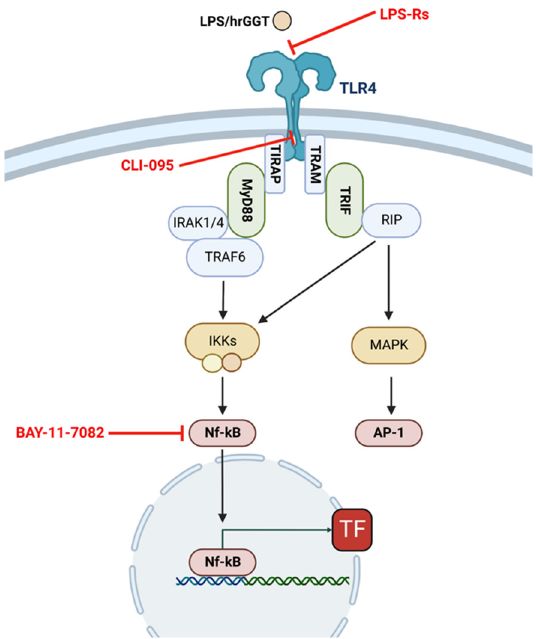
Figure 12. The NF- κ B activation pathway via TLR4 and the mode of action of pharmacological probes formulated to block TLR4 receptor in different signaling steps. TLR4 activation by ligands (LPS or hrGGT) triggers the TLR4 signaling cascade that activates NF- κ B, allowing it to translocate to the nucleus and activate TF gene transcription. Inhibitors are shown in red: LPS-Rs is an extracellular TLR4 antagonist, CLI-095 is an intracellular TLR4 signaling inhibitor, and BAY-11-7082 is a specific NF- κ B inhibitor. The figure was created through the website “biorender.com”.